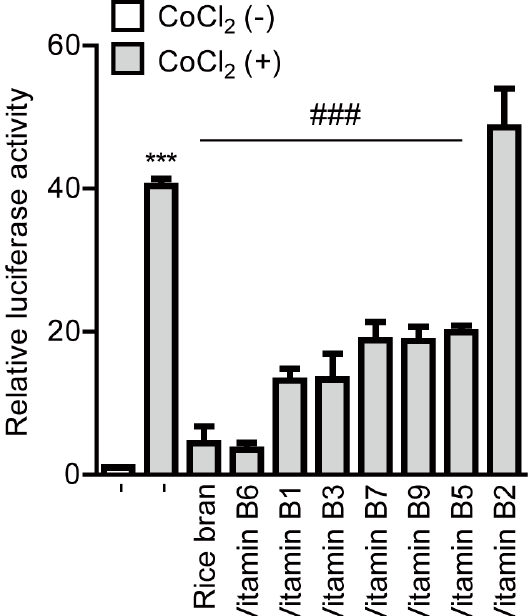
Figure A2. Inhibitory effects of components of vitamin B in rice bran on HIF activity. Quantitative analysis of HIF ‐ reporter luciferase assay using ARPE ‐ 19 cells (n = 3 per group) showed that vitamin B6 dramatically inhibited CoCl 2 ‐ induced HIF activity more than any other components in rice bran. *** p <